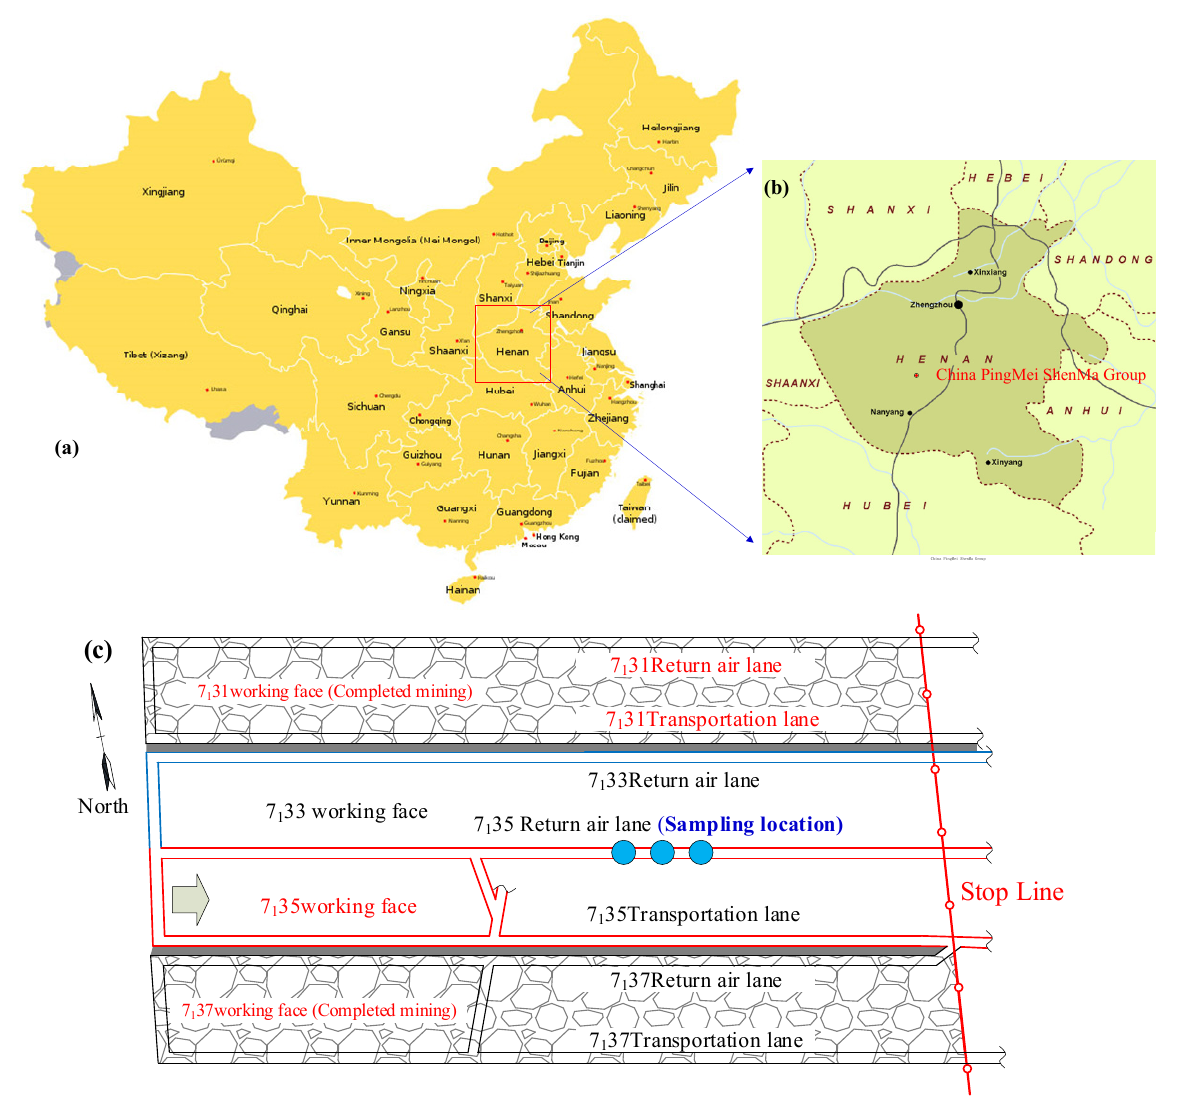
Figure 1. Location of outburst coal sampling. ( a ) The location of Pingmei Shenma Coal Mine in China. ( b ) Location of rock sample collection. ( c ) The coal rock sample was collected at 7 1 35 return air lane.